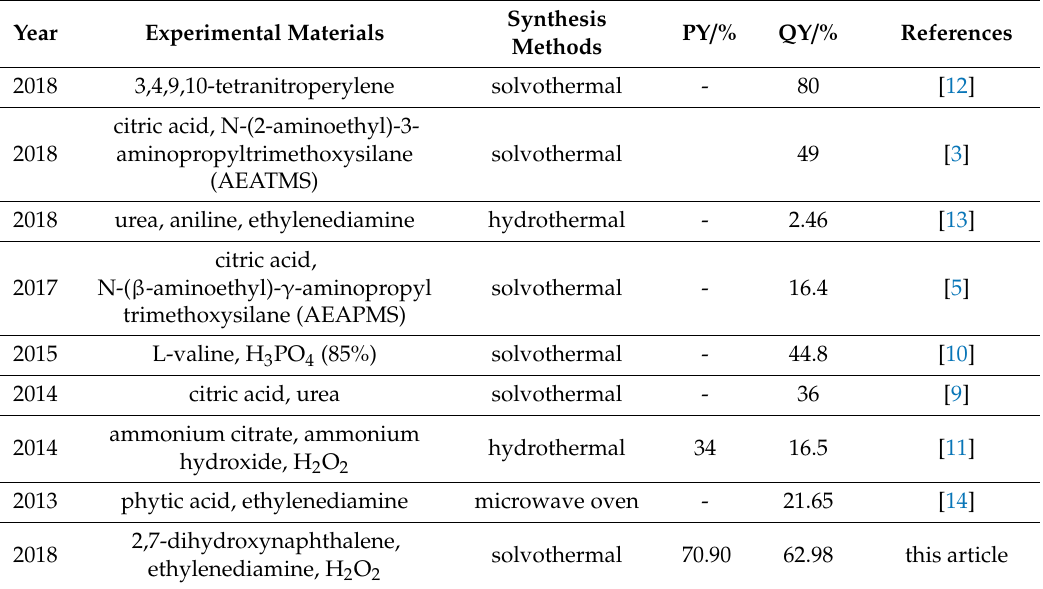
Table 2. A comparison of the QY and PY of g-CQDs synthesised by di ff erent materials and